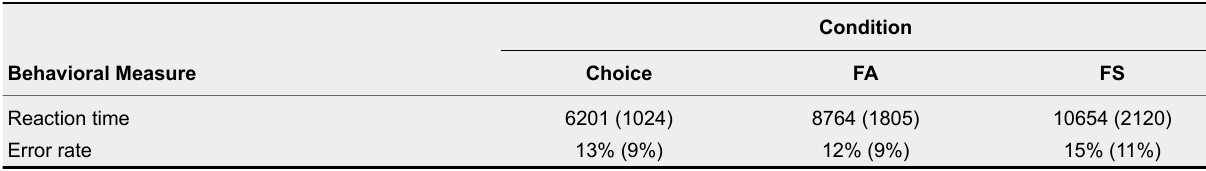
Reaction Times (in Milliseconds) and Error Rates (%) of the Numerosity Judgment Task. Condition Behavioral Measure Choice FA FS Reaction time 6201 (1024) 8764 (1805) 10654 (2120) Error rate 13% (9%) 12% (9%) 15% (11%) Note. FA = forced addition. FS = forced subtraction. Standard deviations are in